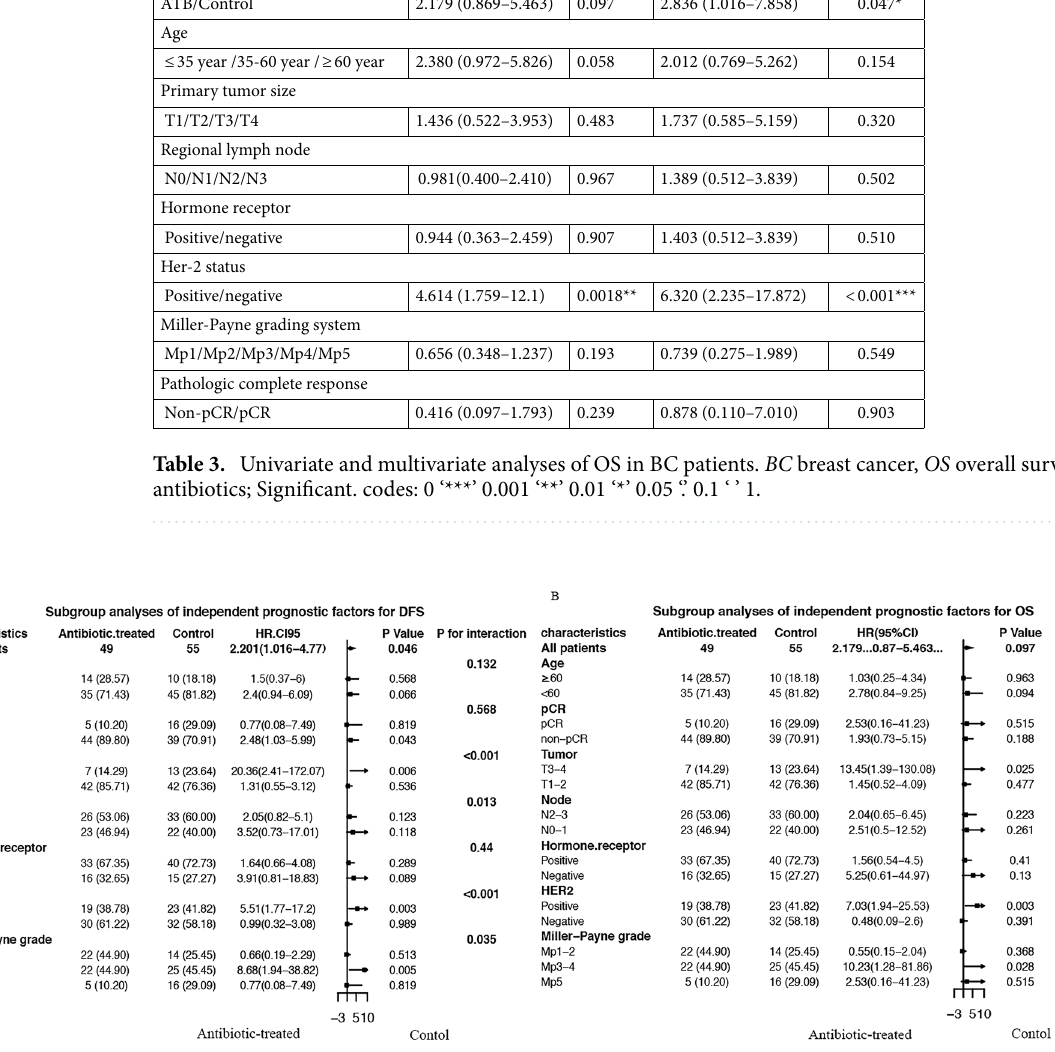
Figure 3. Subgroup analyses of independent prognostic factors for DFS ( A ) and OS ( B